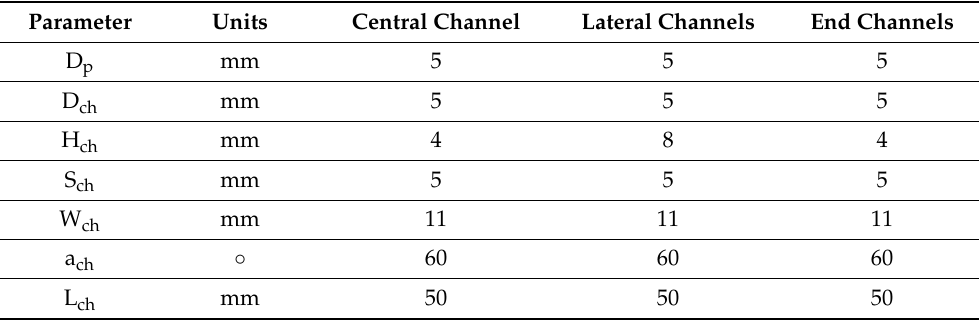
Table 4. Dimensional values of the design parameters used in the cooling of the collimating part in the mold cavity.